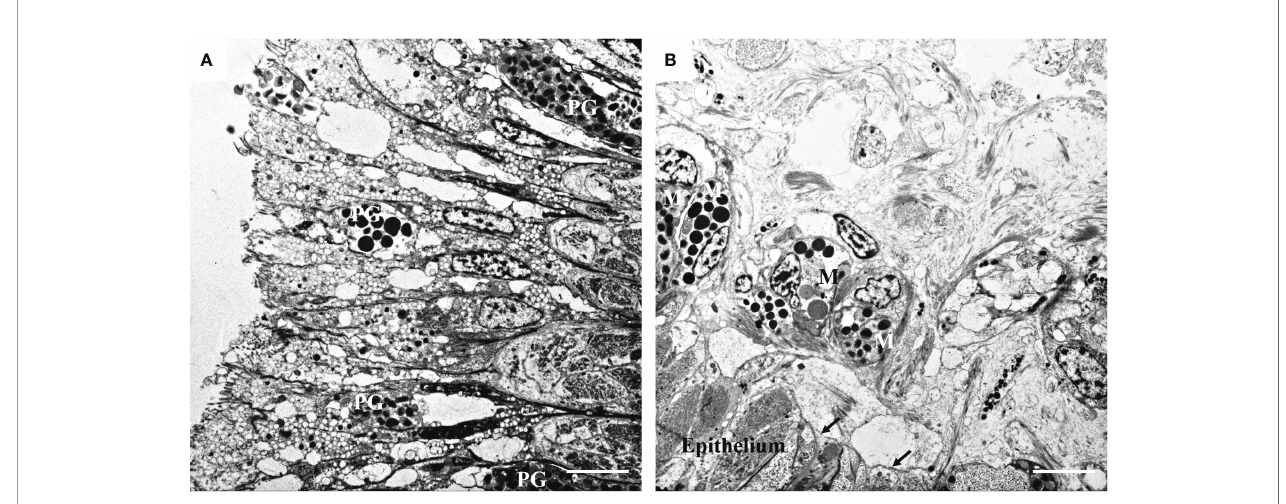
FIGURE 1 | Transmission electron microphotographs of the mantle. (A) Pigmented granules (PG) in mantle epithelium. (B) General view showing the melanocytes (M) and the melanosomes in the melanocytes beneath the basement membrane (arrow). Bar, 5 m